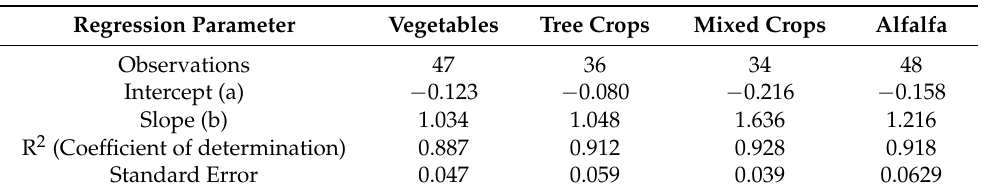
Table 3. Summary of the relationships between Landsat OLI-NDVI and Kc for the irrigated crops in Jordan.